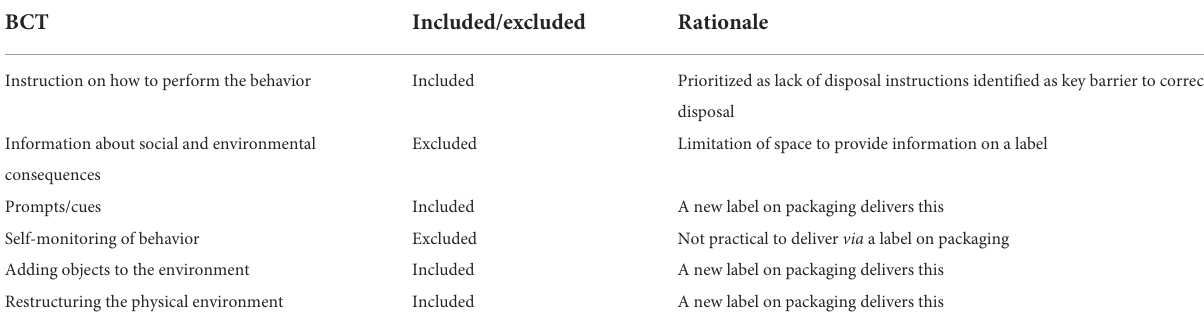
TABLE 6 Narrowing down selection of